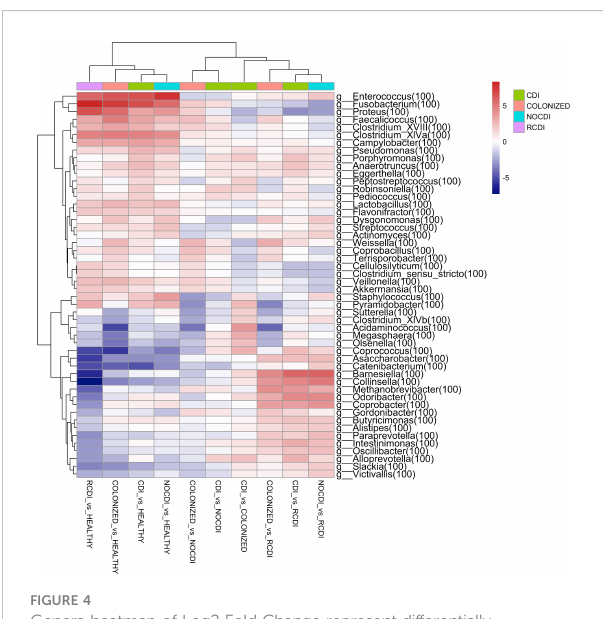
FIGURE 4 Genera heatmap of Log2 Fold Change represent differentially abundance genus between groups. CDI, Clostridioides dif fi cile infection; NOCDI, Non C. dif fi cile diarrhoea; RCDI, recurrent CDI; Colonized, patients colonized with C. dif fi cile ; Healthy, Healthy